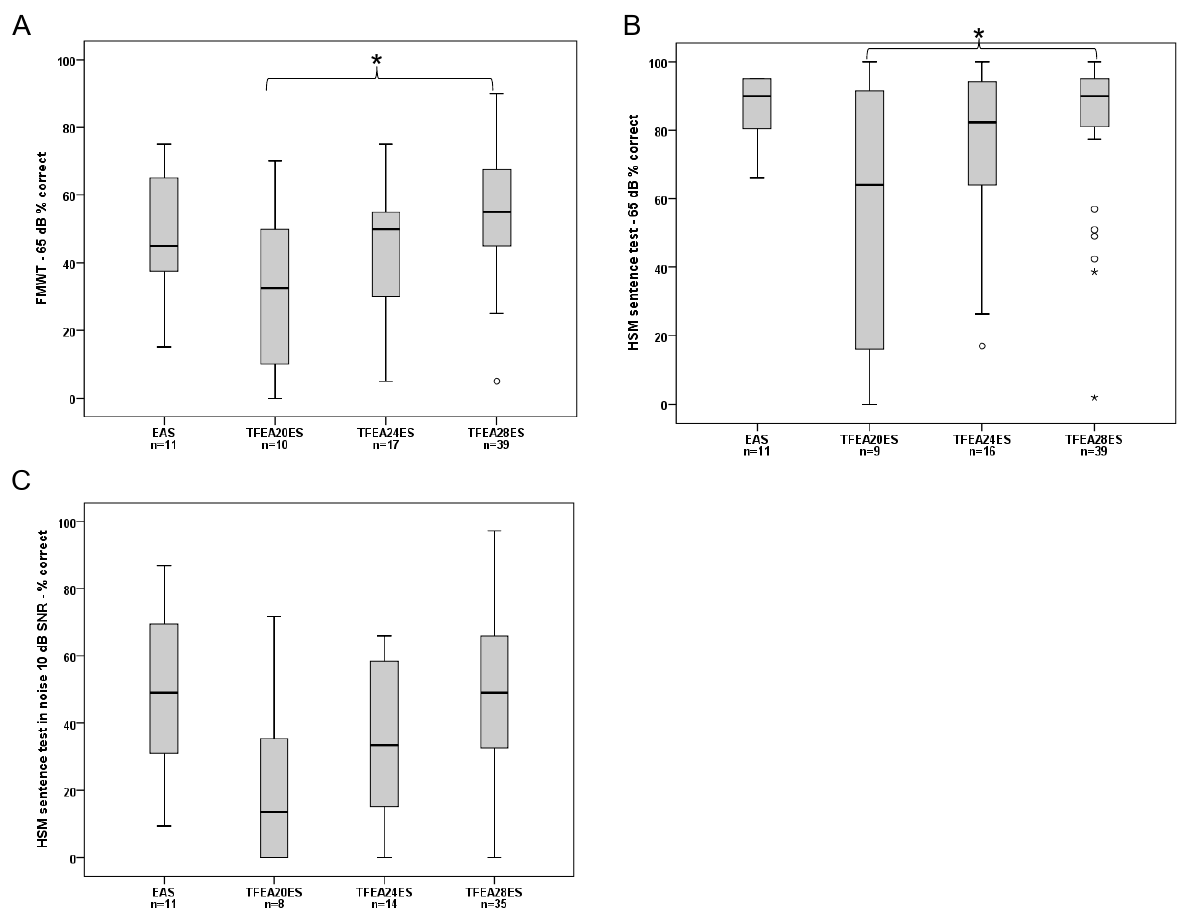
Figure 2. Median, interquartile, and minimum and maximum scores after 12-months: Statistical significances are marked with * for p < 0.05 A ) FMWT, ( B ) HSM sentence in quiet, ( C ) HSM sentence in noise.